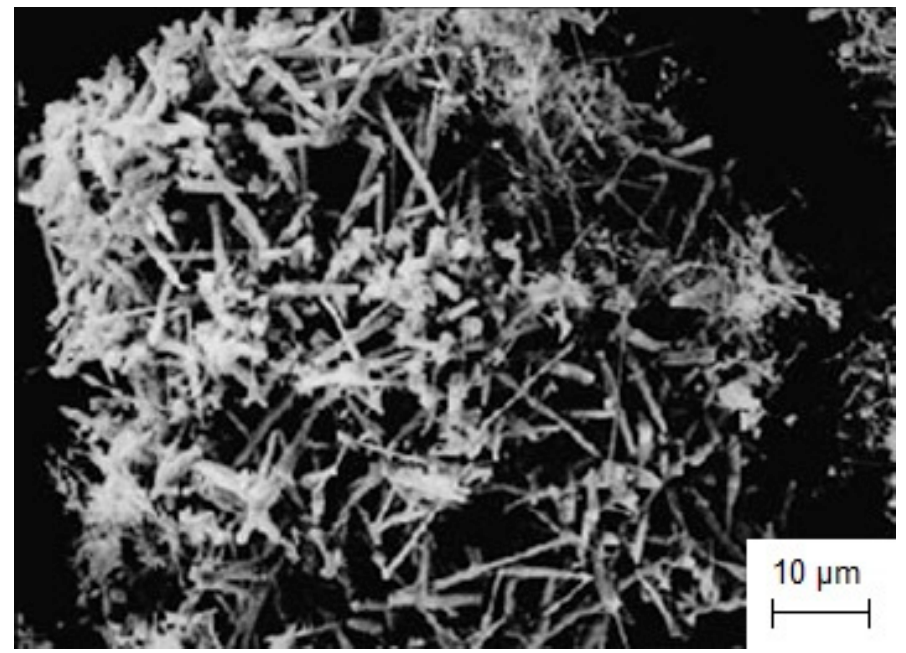
Figure 17. Needle and flake silicon crystals obtained during potentiostatic electrolysis at E = − 0.75 V vs. the glassy carbon electrode, after rinsing the remaining electrolyte off the electrode after its removal from the melt.